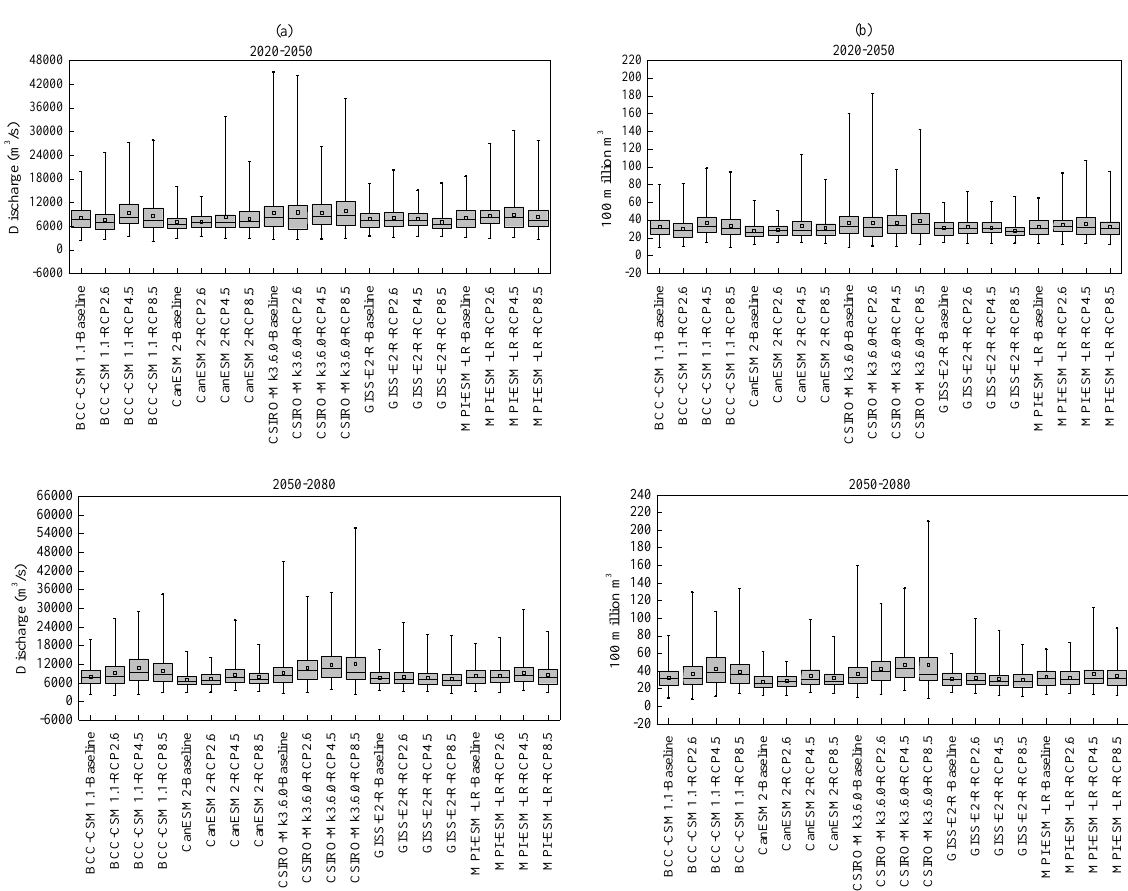
Figure 6. Uncertainty range of (a) AMX1d and (b) AMX7fv under different emission scenarios. Box plots: the central mark is the median; the small square inside the box is the average; the box edges are the 25th and 75th percentiles; the whiskers extend to the 1st and 99th